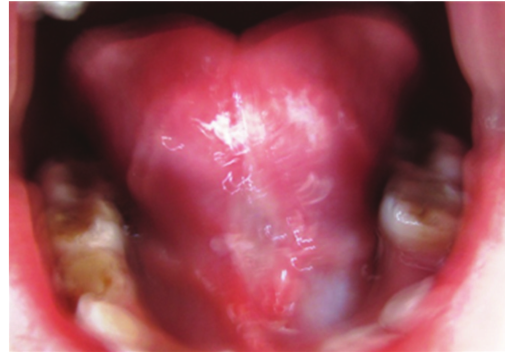
F 6: Postoperative photograph aer 7 days (Case 3).